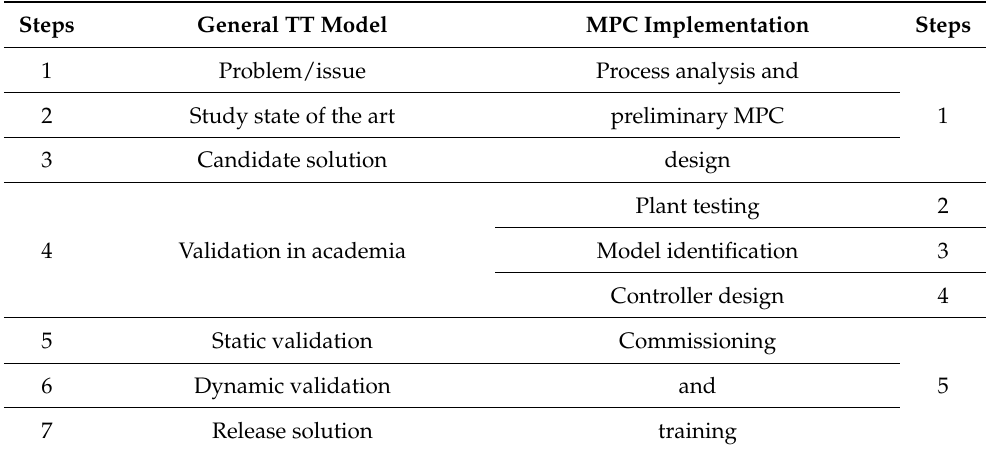
Table 1. The relation of the technology transfer model [20] to the MPC implementation steps as viewed from the perspective of designing and deploying process